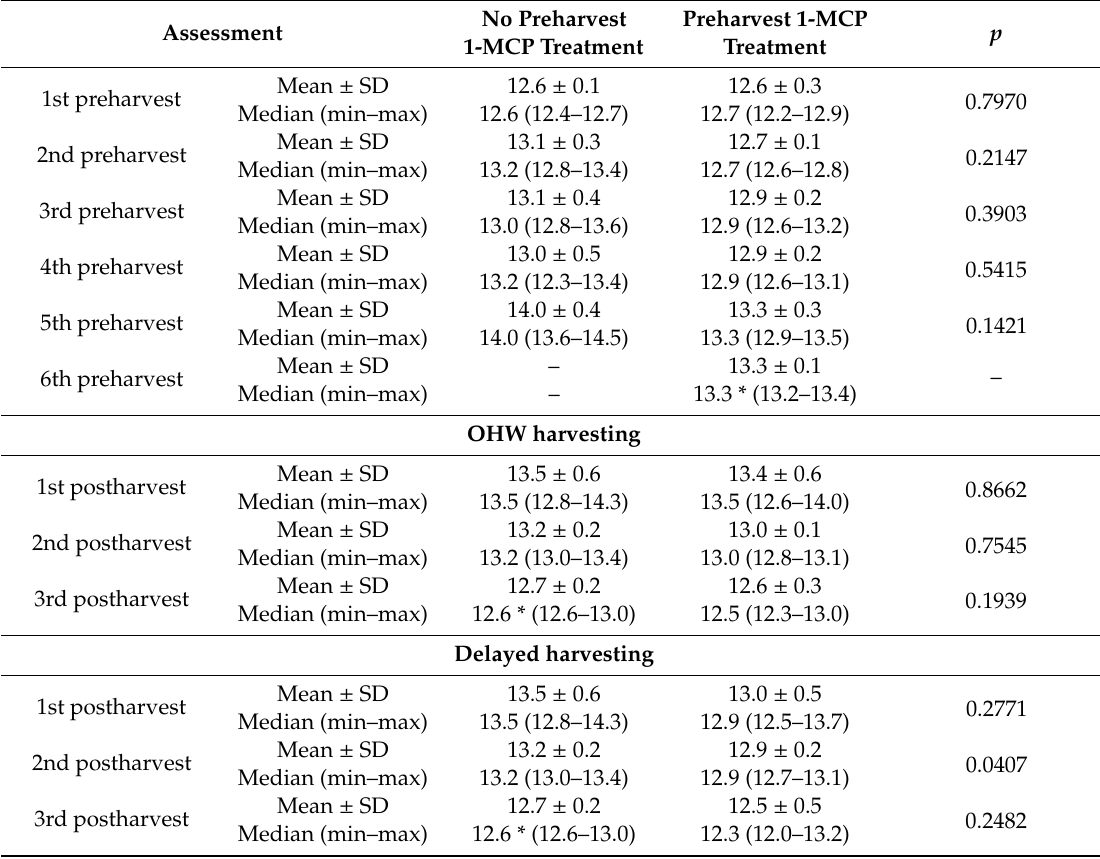
Table 3. Results for total soluble solids content ( ◦ Bx) measured in ‘Szampion’ cultivar apples in the pre- and postharvest periods, compared for groups treated with 1-MCP and a control group not treated with